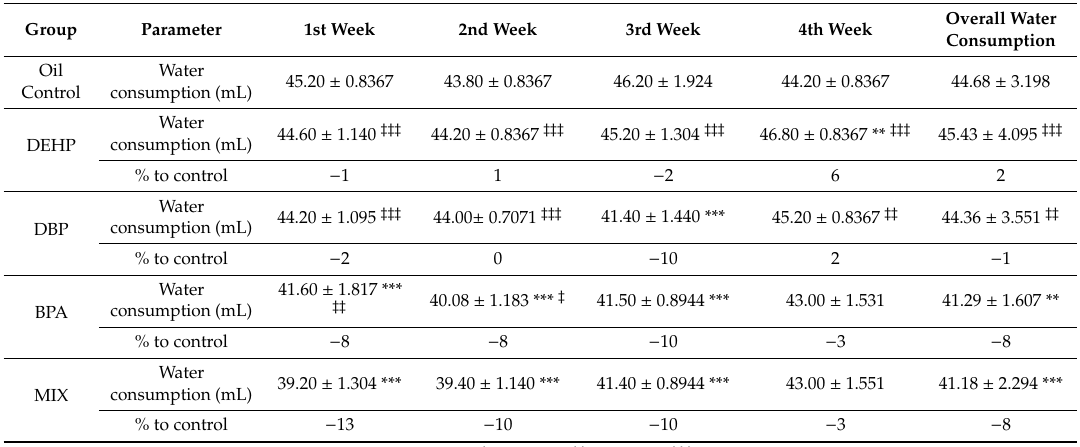
Table 3. Water consumption of rats orally exposed to DEHP, DBP, BPA, and their mixture (MIX) for 28